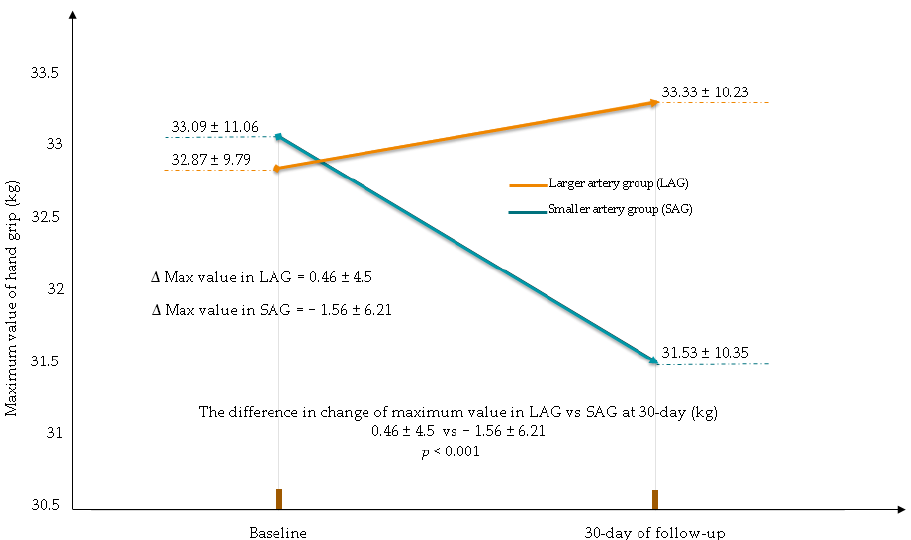
Figure 2. Maximum value reduction in hand grip in used hand for CAG/PCI. CAG—coronary angiography, PCI—percutaneous coronary interventions.